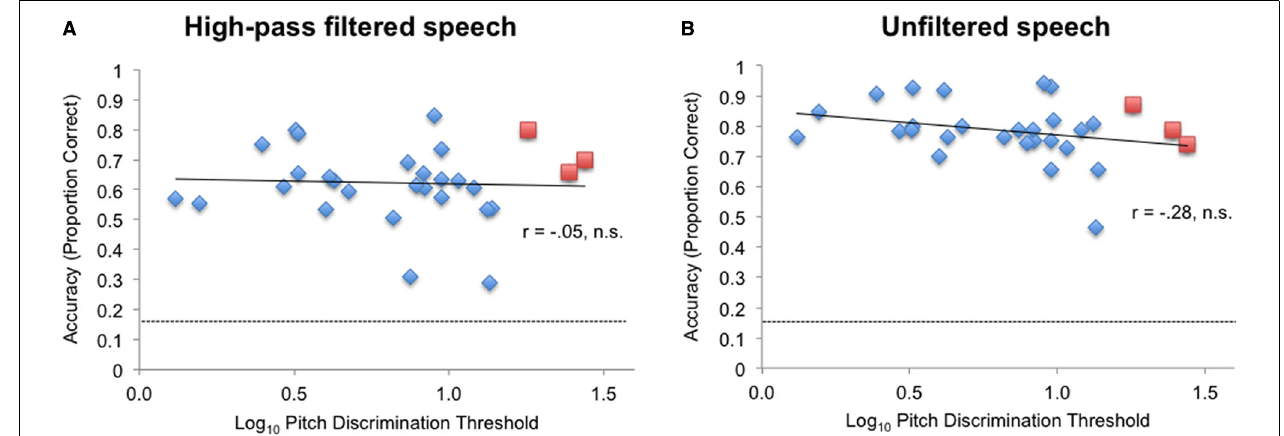
FIGURE 4 | The relationship between log pitch discrimination threshold and emotional identification accuracy (A) in the high-pass condition and (B) in the unfiltered speech condition. Red squares: amusics; blue diamonds: controls. Dashed line indicates chance